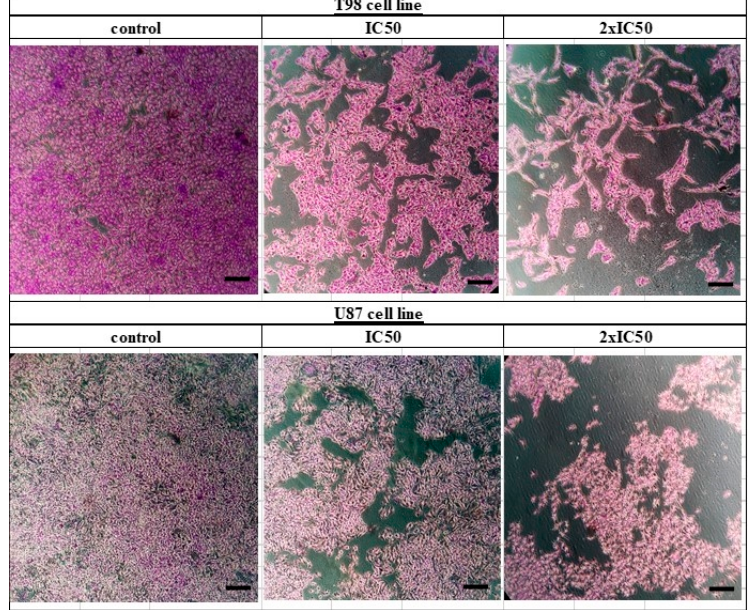
Figure 3. Crystal violet staining (0.2% Crystal Violet) of T98 and U87 cell lines. Cells were seeded in 6-well plates and after 24 h were treated with siderol in concentrations of IC50 and twice IC50 values. Crystal violet solution was added 72 h later. Images were recorded at 10 × magnification. Scales bars = 100 µ